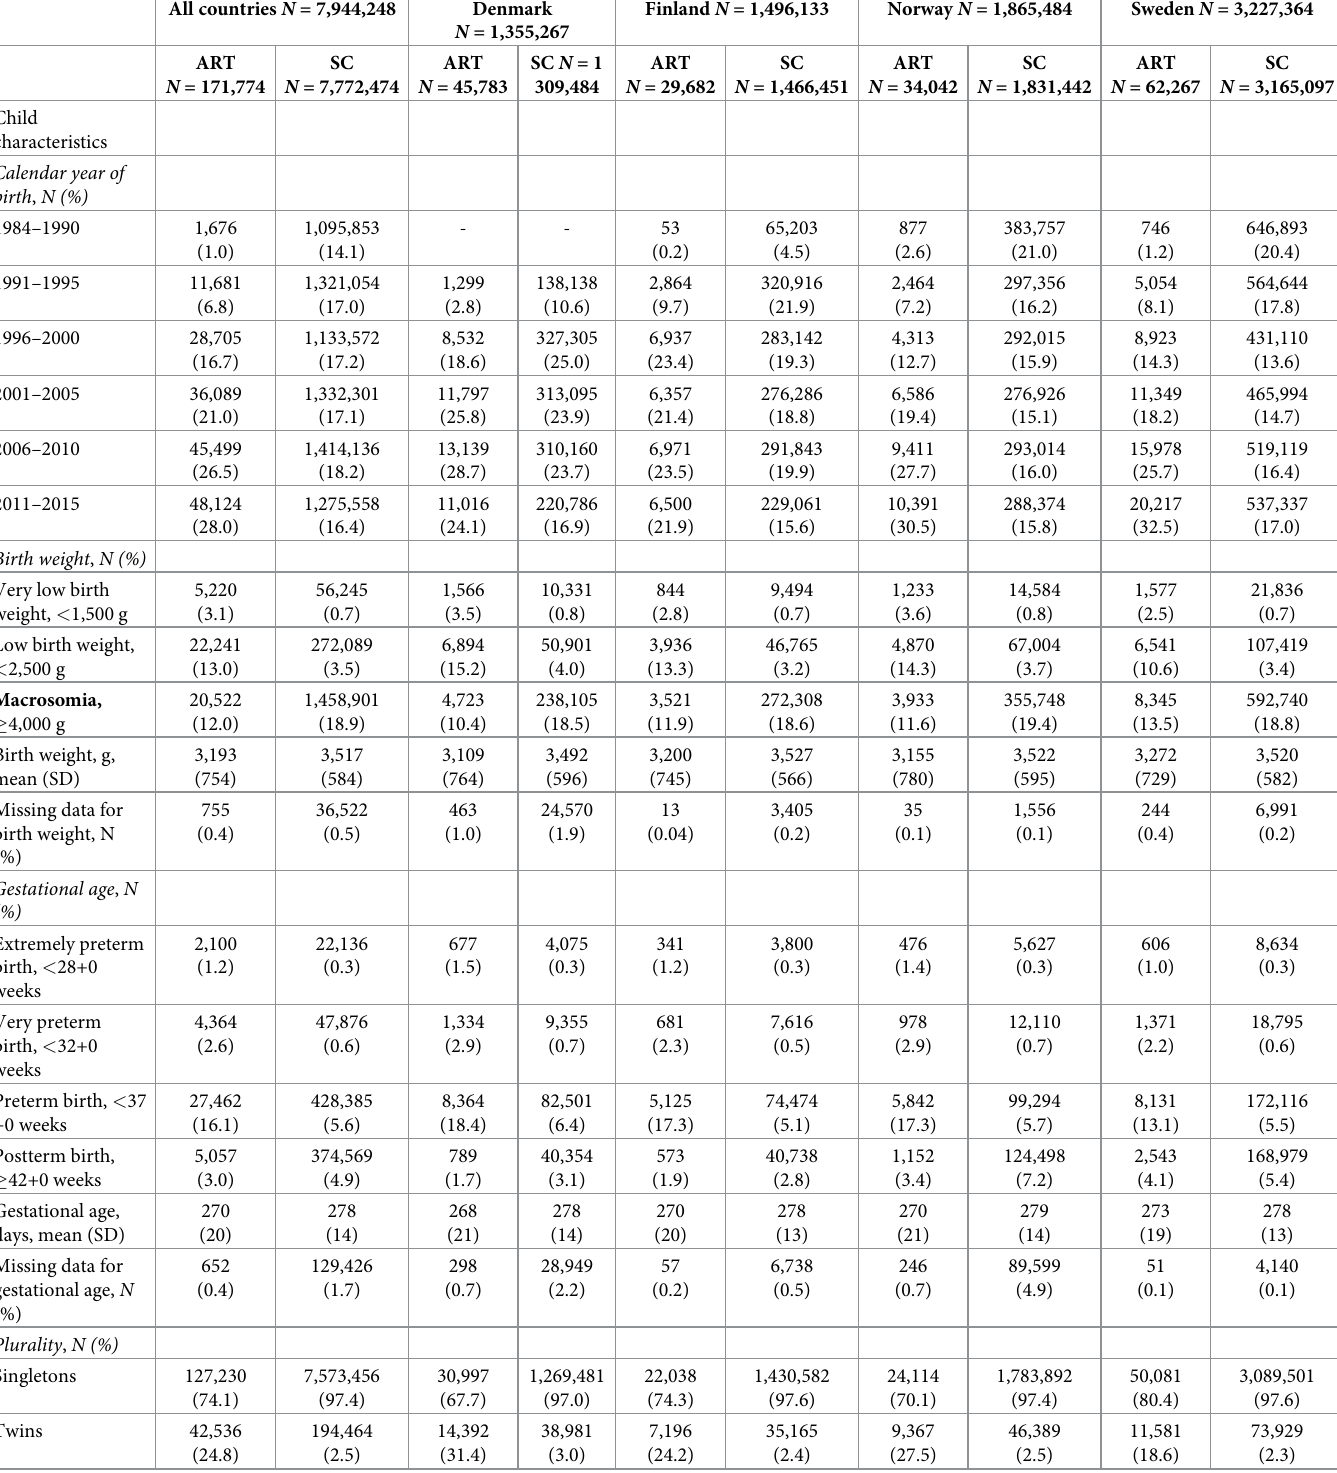
Table 1. Characteristics of study population by mode of conception defined as ART or SC and by country of birth in children born in Denmark 1994–2014, Finland 1990–2014, Norway 1984–2015, or Sweden